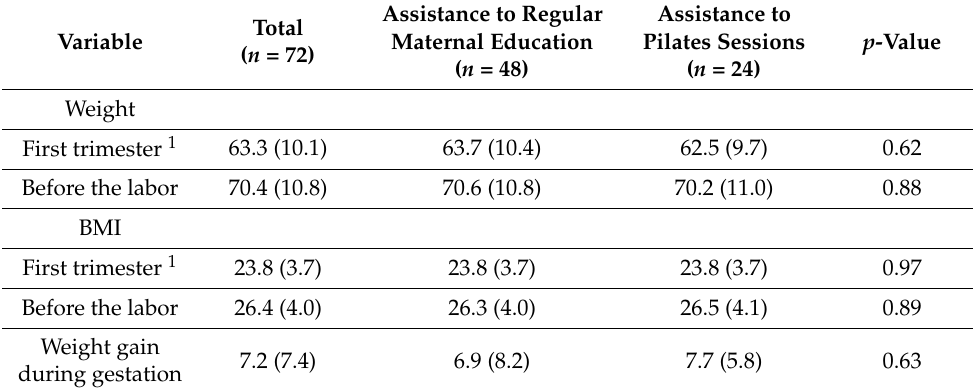
Table 4. Weight gain during gestation.